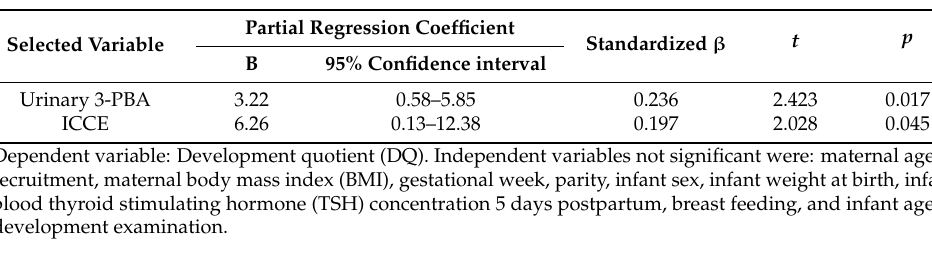
Table 3. Result of stepwise multiple regression analysis (Model 1).